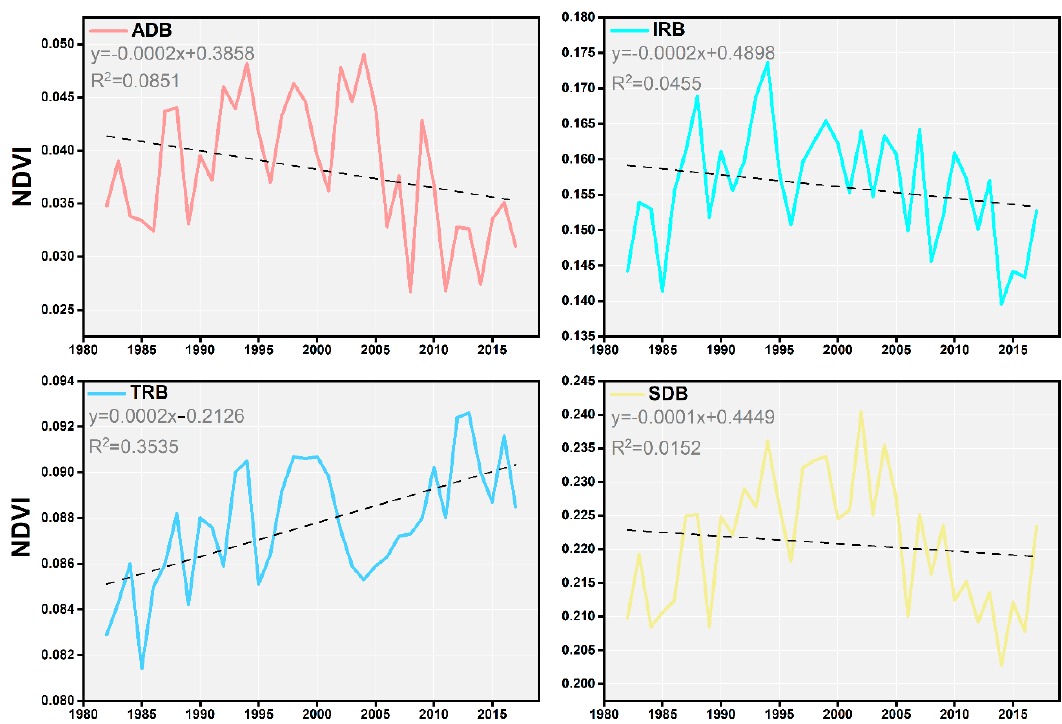
Figure 8. Temporal variations in annual NDVI from 1982 to 2017. ADB, Amu Darya Basin; SDB, Syr Darya Basin; IRB, Ili River Basin and TRB, Tarim River Basin.